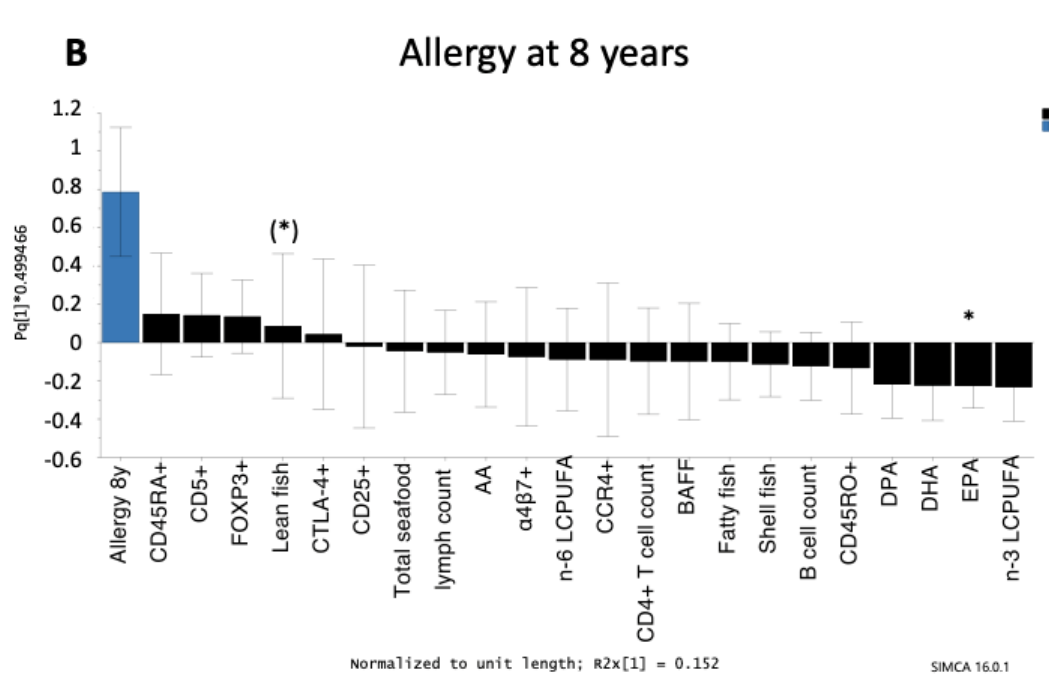
Figure3. Orthogonalprojectiontolatentstructures(OPLS)loadingcolumnplotshowingtheassociations